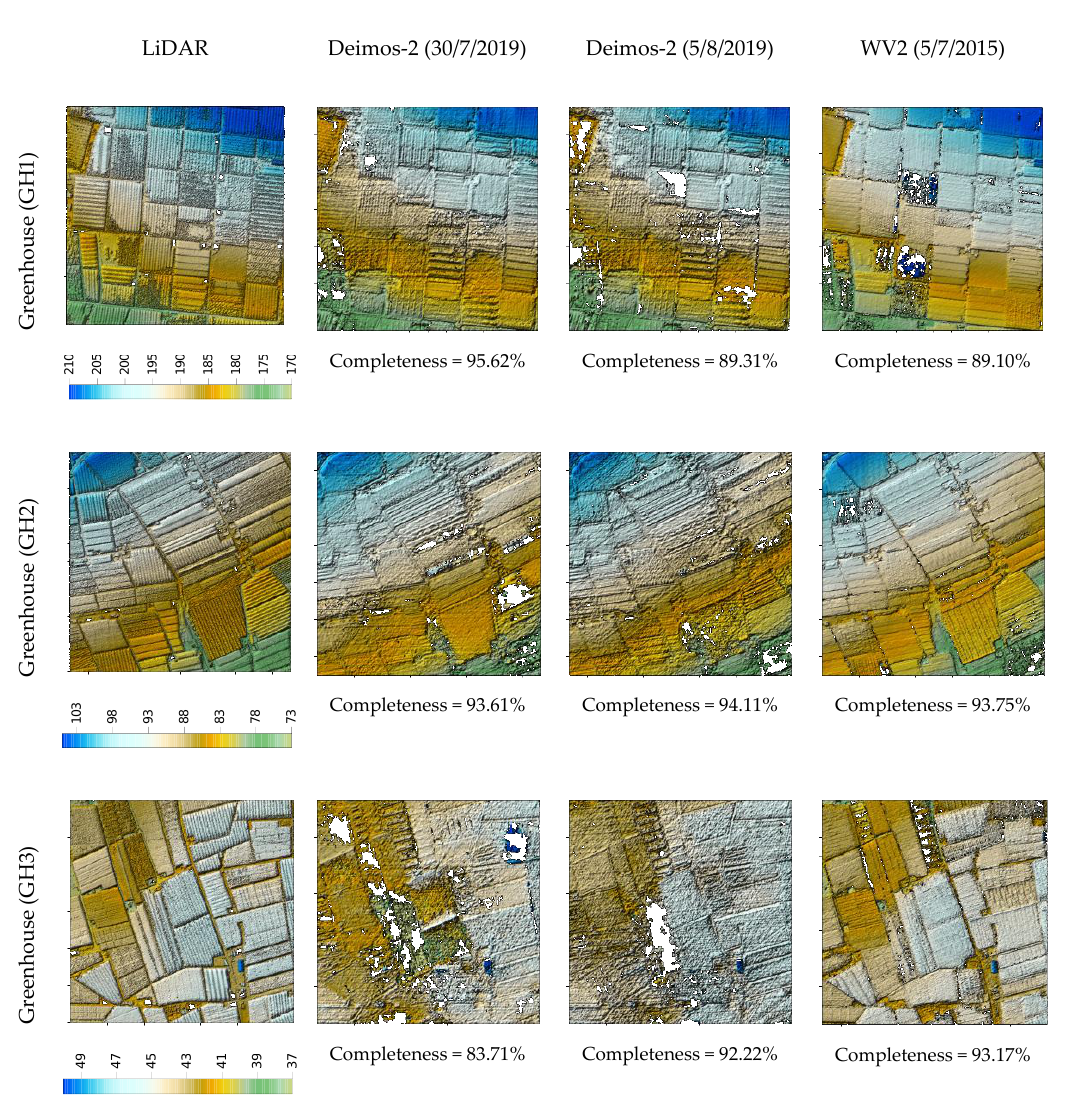
Figure 3. Digital surface models (DSMs) and completeness values corresponding to the three subareas of plastic covered greenhouse land cover (GH1, GH2 and GH3) generated from the first and second Deimos-2 stereo pairs (second and third column) and the WV2 stereo pair (fourth column). The reference LiDAR is depicted in the first column.